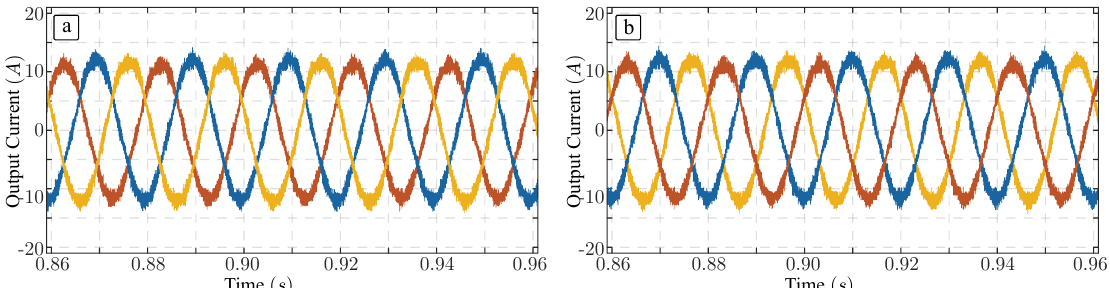
Figure 5. NPC ac currents for a 5.3 kW load. ( a ) PI controller. ( b ) HGO-Adaptive STA proposed